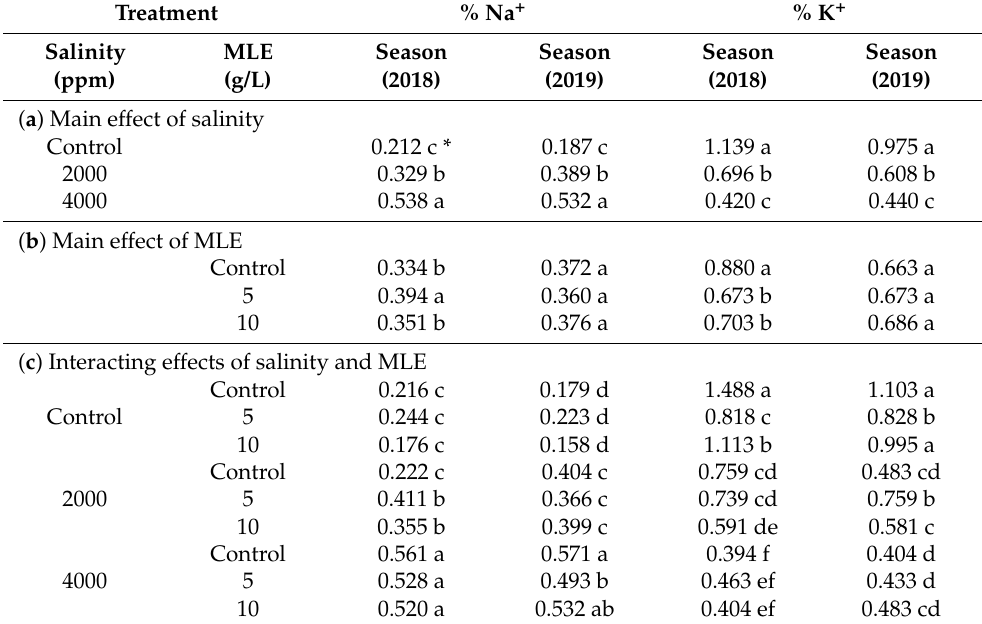
Table 7. Effects of salinity levels, Moringa oleifera leaf extract (MLE) concentrations, and their interactions on the percentages of sodium (% Na + ) and potassium (% K + ) in S. marianum leave samples during the 2018 and 2019 planting seasons. Treatment % Na + % K